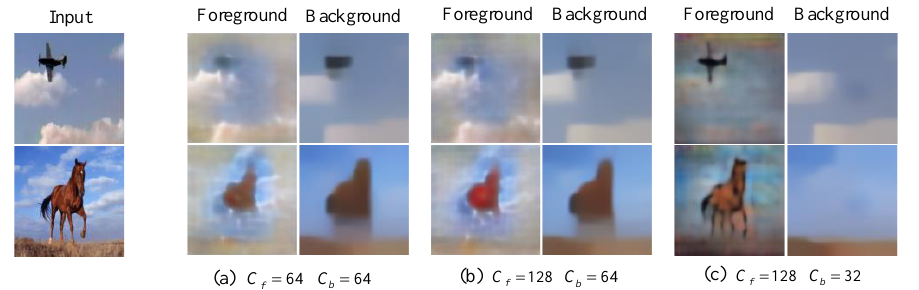
Figure 3. The experimental results of different channel combinations in the foreground and background branches. Appropriate channel combinations can achieve a cleaner foreground and background.